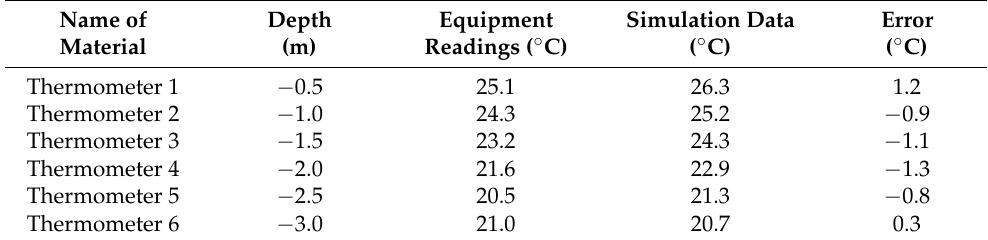
Table 3. Comparison table of measured and simulated data.